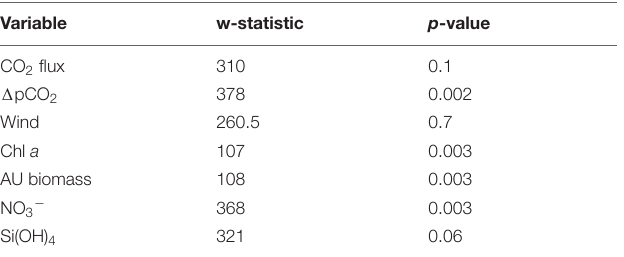
TABLE 2 | Mixed layer depth (MLD) based on density gradient.